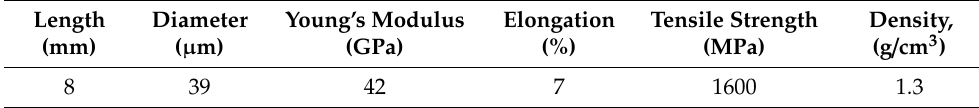
Table 4. Property of PVA